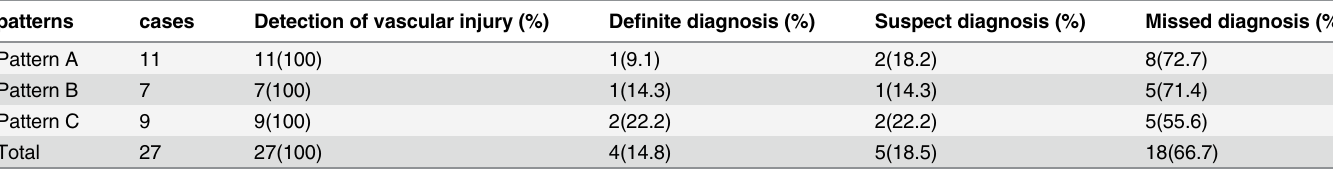
Table 4. Results of duplex ultrasonography examination in diagnosis of multilevel arterial injuries. ▲